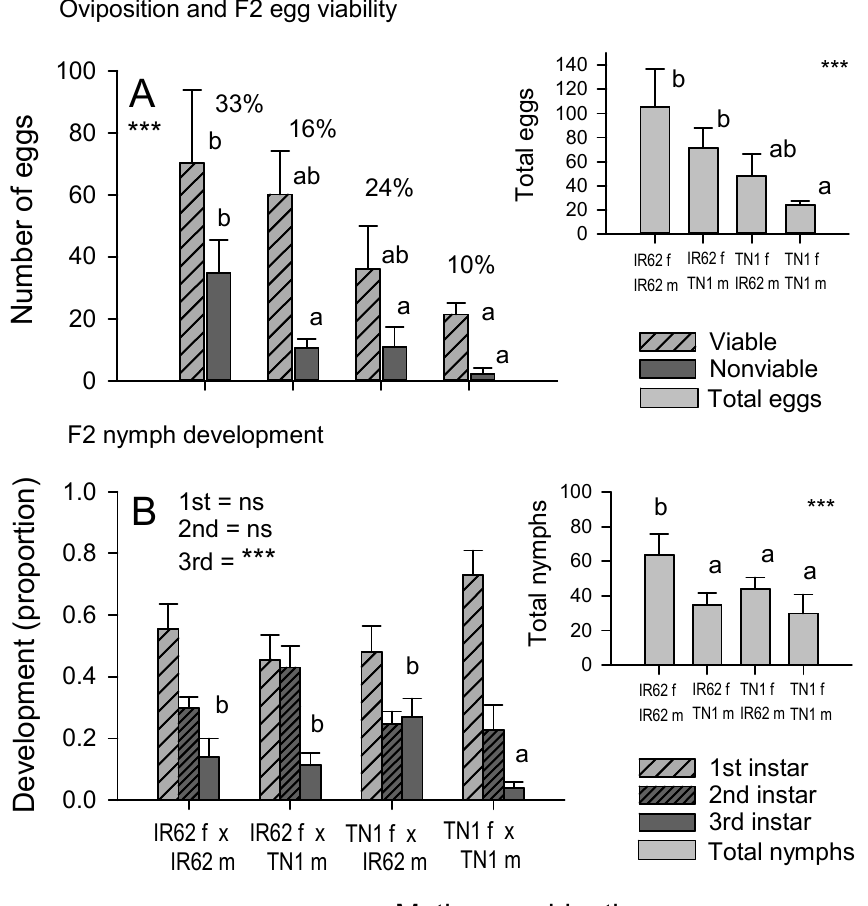
Figure 3. ( A ) Oviposition and ( B ) population development from adults (F1) produced through controlled mating of virulent and non-virulent parents when feeding on the resistant rice variety IR62. Inset graphs indicate the total number of eggs ( A ) and total number of nymphs ( B ) derived from mated pairs. Note that eggs and nymphs are F2 individuals. Standard errors are indicated (N = 12). NS = no significant parent effect, *** = highly significant parent effect ( p ≤ 0.001). Lowercase letters indicate homogenous groups (Tukey p > 0.05). Egg and nymph numbers were log-transformed and proportions arcsine-transformed before analyses.